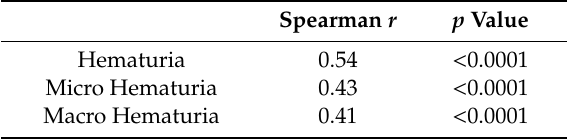
Table 4. Correlation between presence of UCSI and Hematuria levels of Total / Micro /